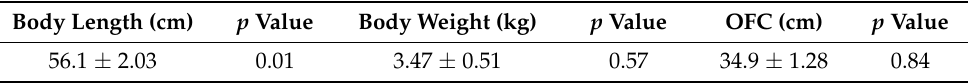
Table 2. Mean birth parameters in comparison with the male general population. Body length: 52.2 cm; body weight: 3.5 kg; OFC: 35.3 cm.